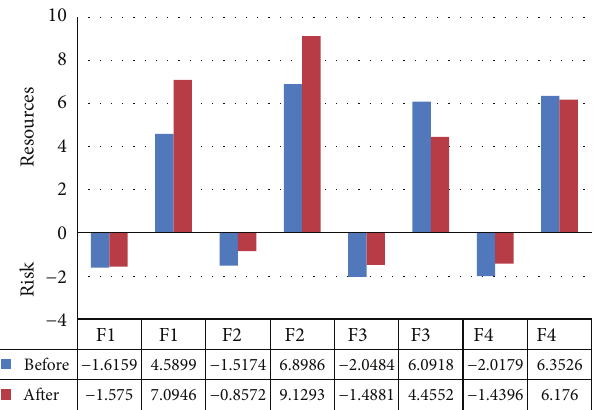
Figure 2: Factorial distribution of changes in distress for health resources and risks. ∗ F1: mental, F2: dyspeptic, F3: respiratory, F4: asthenic latent